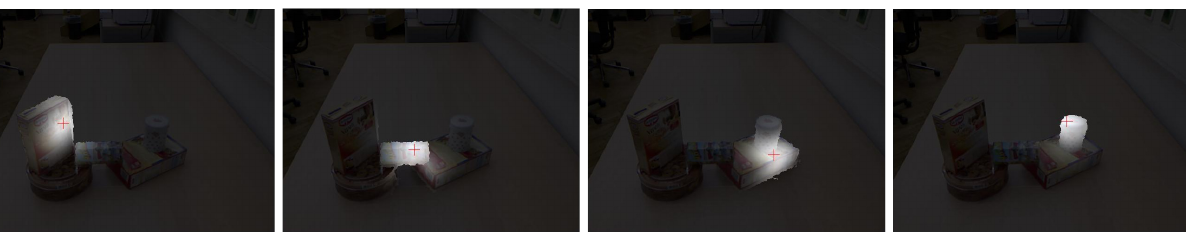
Figure 3. Examples of modeling hypothesized objects from 4 seed points (denoted by the red plus), respectively, to obtain probability maps defined on all